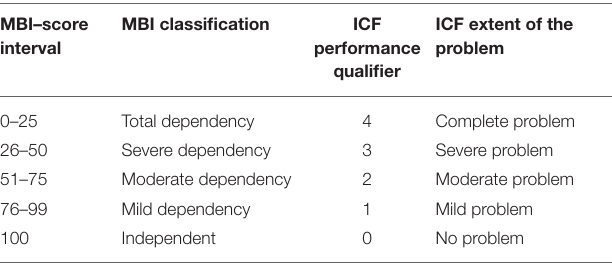
TABLE 6 | Percentage of Patients that Migrated through AL